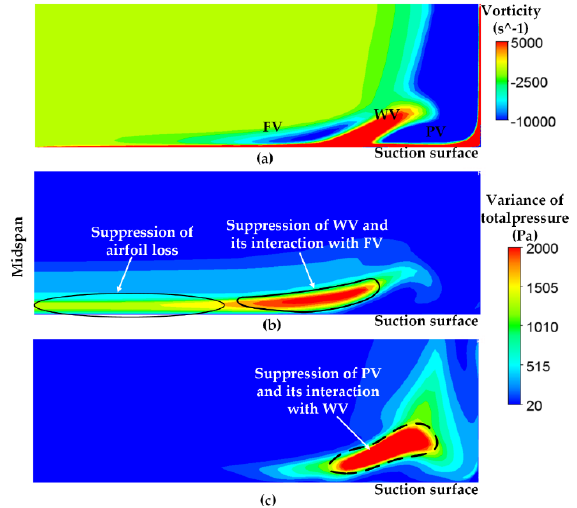
Figure 11. Influences of plasma actuations on the total pressure at plane p6 and the corresponding main flow structures. ( a ) Main flow structures at plane p6 of baseline condition; ( b ) Variance of total pressure with the suction surface plasma actuation; ( c ) Variance of total pressure with the endwall plasma actuation.